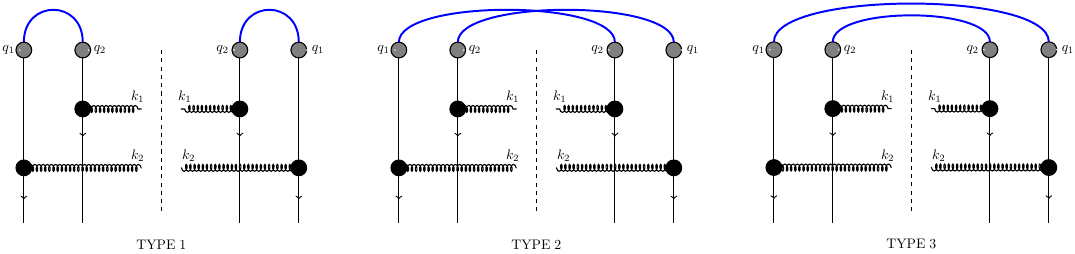
Figure 1 . Diagrams corresponding to the glasma graph calculation of two-particle correlations. See the text for